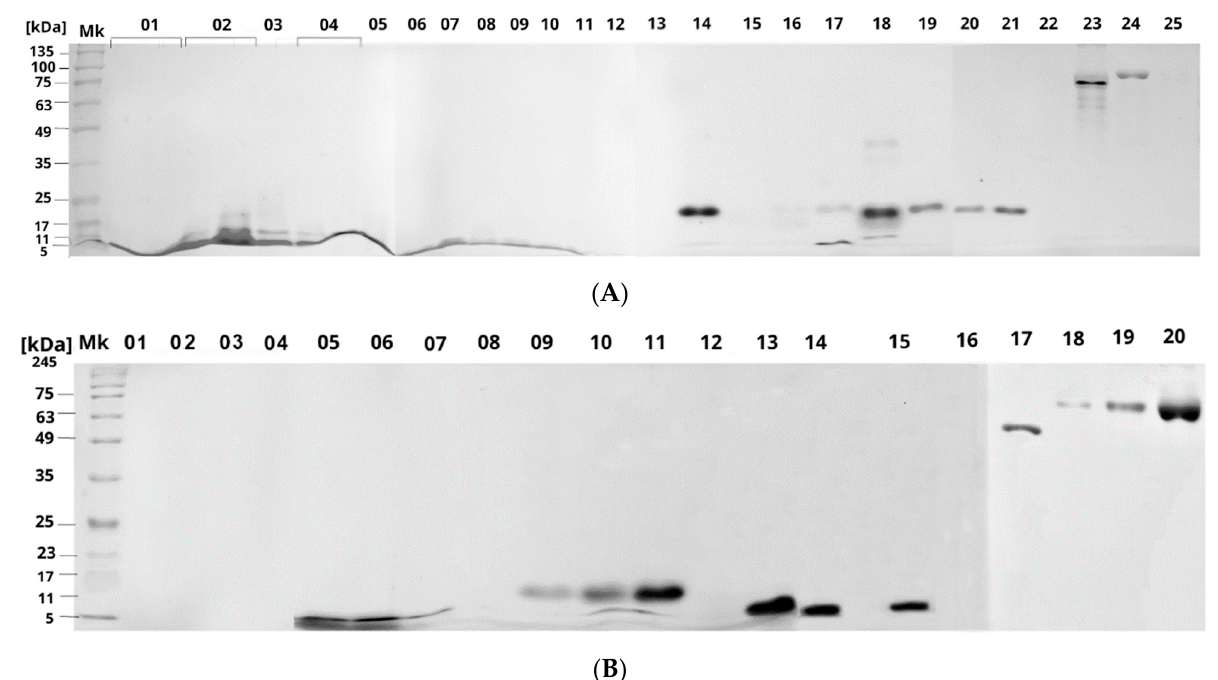
Figure 4. Electrophoretic profiles of Ecuadorian coral snake venom fractions of ( A ) Micrurus helleri and ( B ) Micrurus mipartitus . Low-molecular mass proteins (5–17 KDa) are highly abundant in these two samples of Ecuadorian elapids. The last chromatographic fractions contain higher molecular mass toxins, around 60 KDa.